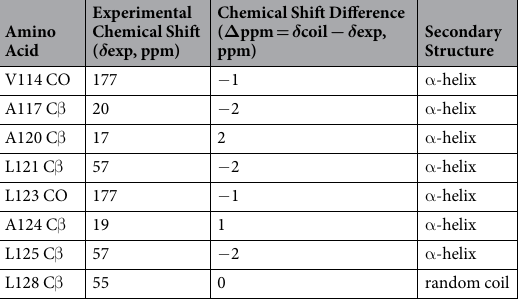
Table 2. The secondary structure of the transmembrane region of cytochrome b 5 determined by DNP sensitivity-enhanced ssNMR spectroscopy. TT V DS-NSS WW 110 -TN WV I-P A IS A 120 - L I VAL -MYR L Y 130 - M A DD. The secondary structure of transmembrane regions of cytochrome b 5 determined by DNP sensitivity- enhanced ssNMR spectroscopy using selectively 13 C-labeled cytochrome b 5 incorporated into DMPC bilayers with AMUPol at 99.5 K sample temperature; assigned chemical shifts of selectively 13 C-labeled cytochrome b 5 incorporated into DMPC bilayers are given in Supplementary Table S2 and that of DMPC are given in Supplementary Table S3. The C-terminal α -helix transmembrane domain of amino acid sequence of rabbit cytochrome b 5 is shown at the bottom of the Table. The region 105–127 is the hydrophobic α -helical transmembrane region.Selectively 13 C-labeled amino acids are highlighted in bold in the amino acid sequence, and assigned 13 C resonances in these labeled amino acids are underlined. The 13 C resonances were assigned utilizing the two dimensional 13 C- 13 C PDSD chemical shift correlation spectrum shown in Fig. 2A; the reported chemical shift values are within an error of ~0.5 ppm as the use of selective labeling enabled a better measurement of the peak position in the spectra, while the use of single amino acid labeled protein in DNP experiments could further assist in the resonance assignment by overcoming the overlapping resonances; but, this would be very expensive, particularly for membrane-associated proteins for which the yield is typically low and the production cost is very high. The secondary structure-dependence of empirical 13 C chemical shifts were obtained from a previous report 103